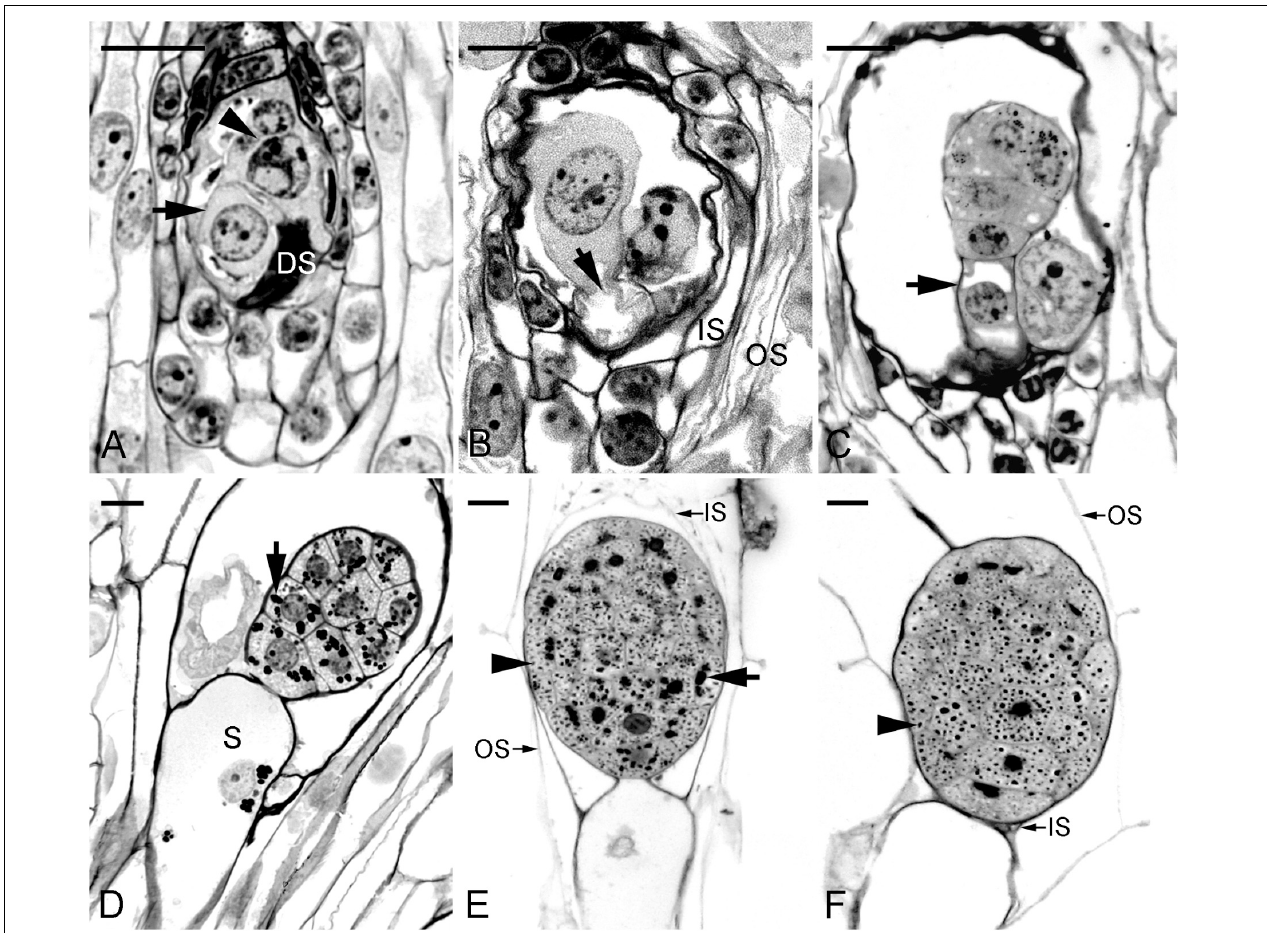
FIGURE 1 | Light micrographs showing the embryo of Phaius tankervilliae at different stages of development. (A) A zygote (arrow) after fertilization at 40 days after pollination (DAP). In this species, the endosperm fails to develop, and the polar-chalazal complex (arrowhead) includes the chalazal nuclei and the polar nuclei. DS, degenerated synergid. (B) Elongated zygote at 45 DAP. Before the first cell division, the zygote is highly polarized with a nucleus located toward the chalazal end and a prominent vacuole (arrow) occupying the micropylar end. IS, the inner seed coat; OS, the outer seed coat. (C) Longitudinal section through a proembryo at 60 DAP. Vacuoles begin to enlarge at the suspensor cell (arrow). (D) Longitudinal section through a globular embryo with an enlarged single-celled suspensor (S) at 75 DAP. A number of starch grains (arrow) are present in the cells of the embryo proper. (E) Longitudinal section through a near-mature embryo at 90 DAP. At this stage, the suspensor has degenerated. Many starch grains (arrow) and protein bodies (arrowhead) are present in the cells of the embryo proper. The inner seed coat (IS) is dehydrating and compressing. (F) Longitudinal section through a mature embryo at 105 DAP. At this stage, the suspensor has degenerated. At maturity, the embryo is enveloped by the shriveled IS and the OS. Starch grains have disappeared and protein bodies (arrowhead) of various sizes are observed within the embryo proper. Although lipids could not be preserved in Historesin, plentiful translucent vesicles within the cytoplasm of embryo proper indicate the deposition of lipid bodies. Scale bar = 20 µ